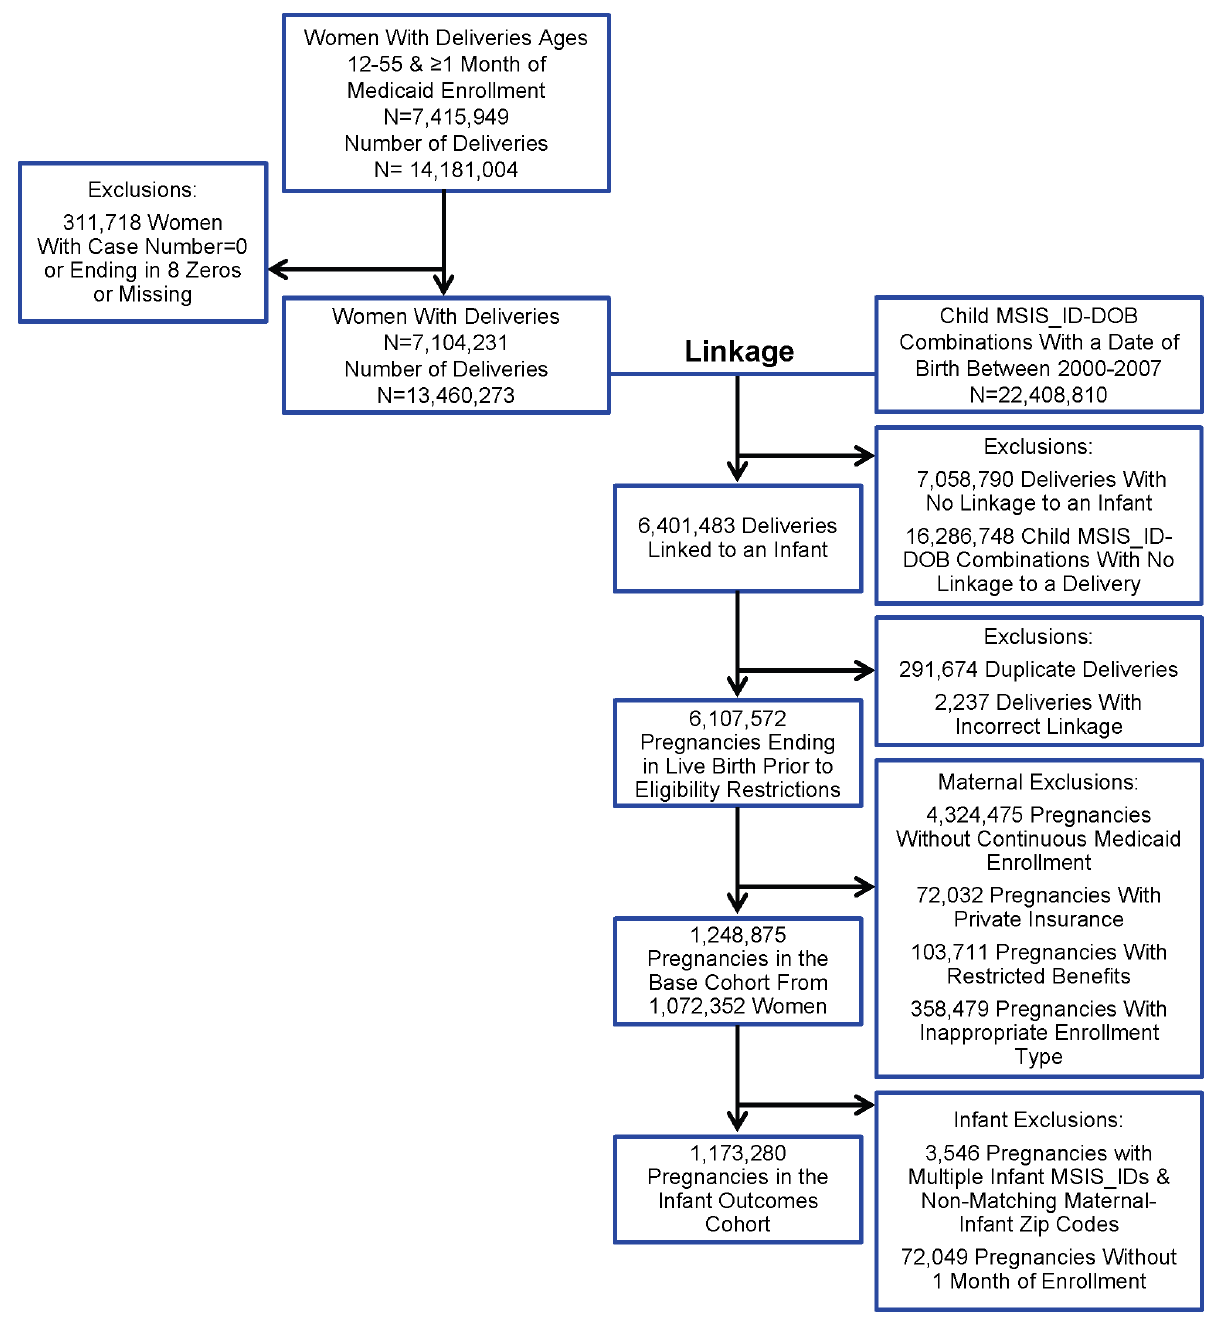
Figure 1. Overview of the linkage and cohort identification process; Medicaid Analytic eXtract, 2000–2007.